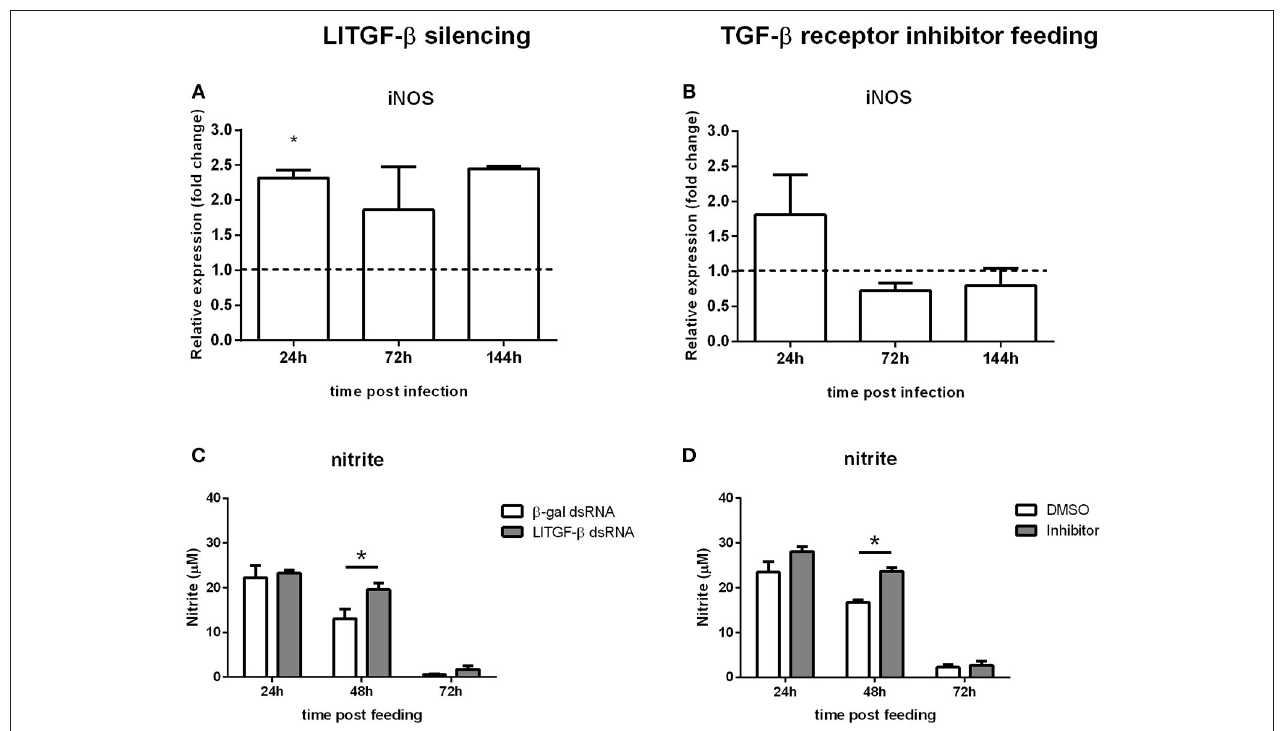
FIGURE 4 | Nitric oxide production in sand flies abrogated for the LlTGF- β signaling pathway. (A) iNOS gene expression of LlTGF- β silenced insects, (B) fed with blood containing TGF- β receptor inhibitor, both (A,B) infected by L. i. chagasi . Samples were collected at 24, 72, and 144h post infection. Dotted line indicates gene expression of control group, β -gal dsRNA injected or blood containing DMSO fed flies. Bars represent mean with standard error of fold change in gene expression relative to control groups of three independent experiments. Significant differences were evaluated by t -test and Mann-Whitney post-test. (C) NO measurement in LlTGF- β silenced sand flies fed on blood. (D) Nitrite measurement in flies fed on blood containing TGF- β receptor inhibitor. Bars represent mean with standard error of nitrite measurements in test and control groups of 3 independent experiments. Significant differences were evaluated by t -test and Mann-Whitney post-test (* p <